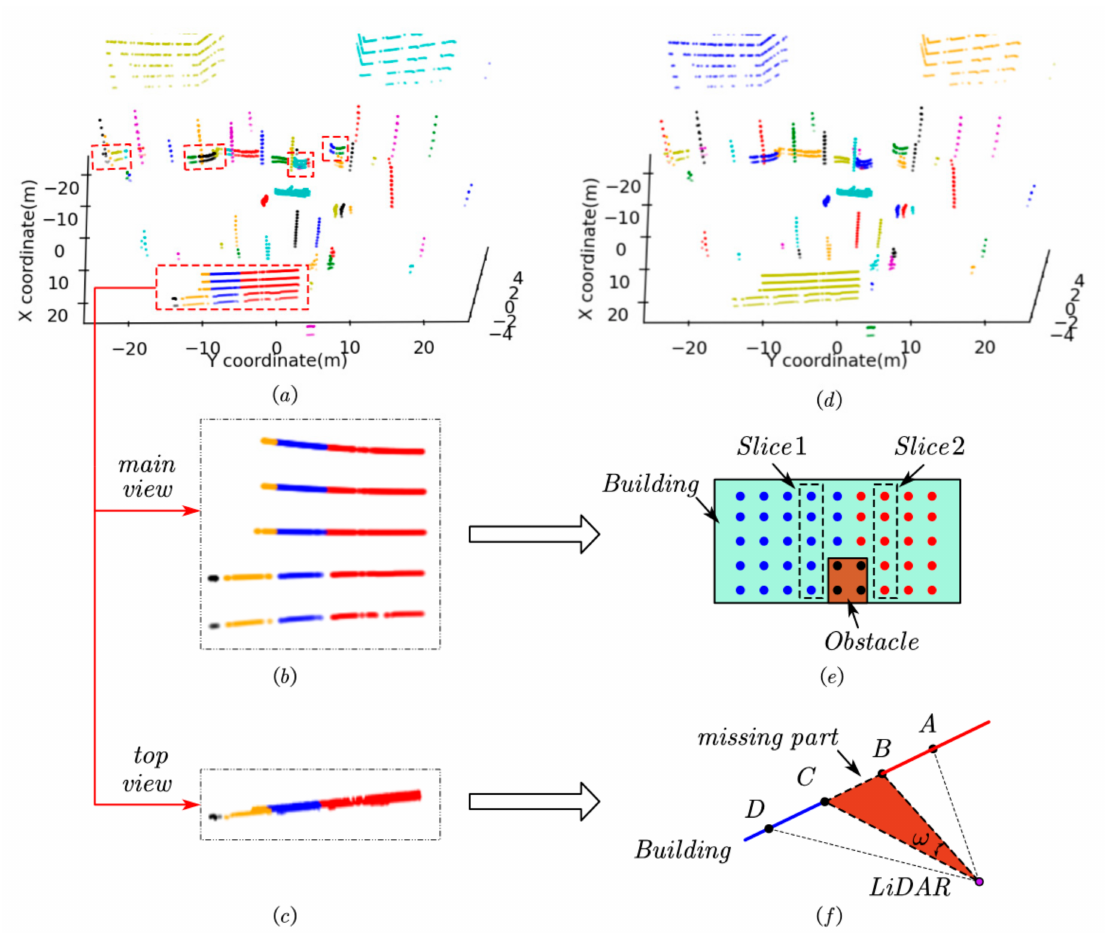
Figure 9. Fusing major parts. ( a ) Before fusing major parts, where colors are randomly generated and di ff erent colors mean di ff erent classes; ( b ) Main view of the obscured building; ( c ) Top view of the obscured building; ( d ) After fusing major parts, where colors are also randomly generated; ( e ) Schematic diagram of main view of the obscured building; ( f ) Schematic diagram of top view of the obscured